Question: Express in one sentence what the figure is showing.
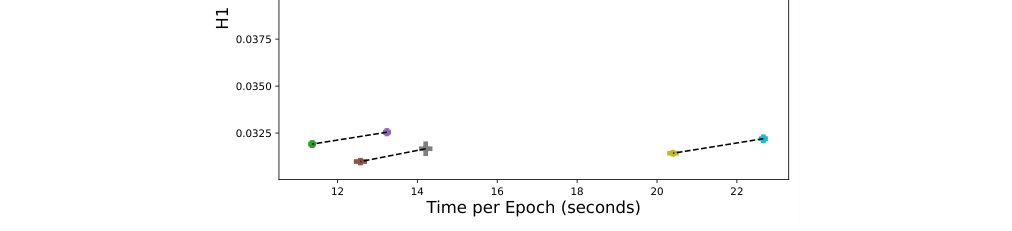
Answer: Comparison of the Full-FNO and Mixed-FNO with different frequency modes on the Darcy Flow dataset. For 16 frequency modes, the half precision error (compared to full precision) is higher than for 32, 64, or 128 modes.